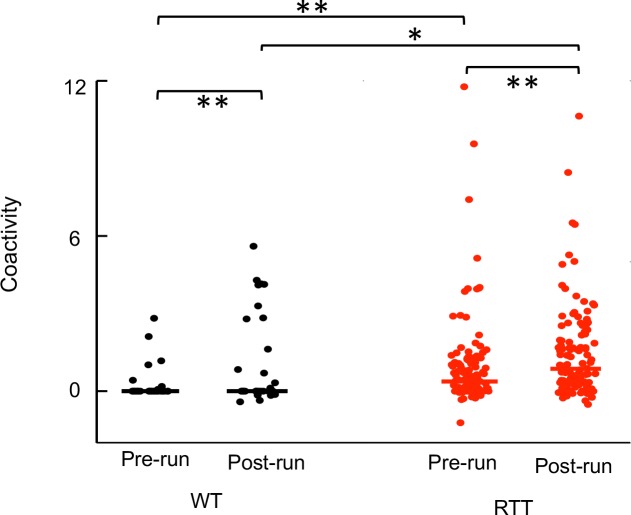
Run-active cells in RTT mice displayed enhanced firing synchrony before (Pre-run) and after (Post-run) running on the familiar track.The plot shows coactivity of all run-active cell pairs in WT and RTT mice within ripple events in Pre-run and Post-run. Solid lines: median values. Number of pairs recorded during all sessions of Pre-run, Run 1, and Post-run: N = 32 (WT), 119 (RTT). WT coactivity between Pre-run and Post-run: **p=0.0076, paired Student’s t-test; RTT: **p=0.0014. Pre-run coactivity between WT and RTT mice: **p=0.0015, Wilcoxon ranksum test; Post-run: *p=0.012.